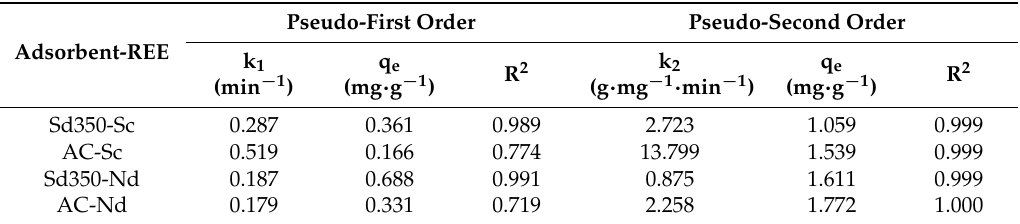
Table 2. Parameters of the pseudo-first and pseudo-second order of Lagergren kinetic models for Sc and Nd adsorption on biochar Sd350 and activated carbon (AC).